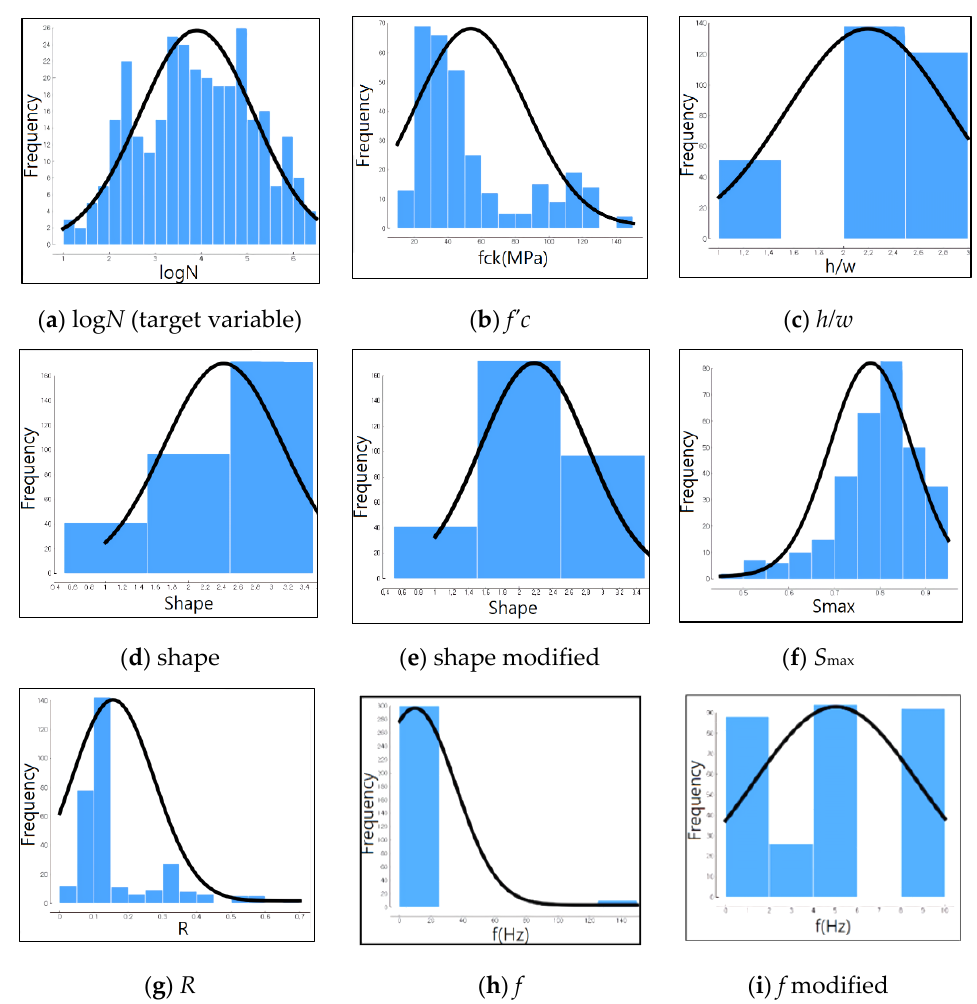
Figure 1. Distribution of frequency of the variables used to run the models. The relationships between various independent variables and log N are plotted in Figure 2. Although not strong, one linear relationship is identified in Figure 2a (log N vs. S max ). All other plots show non-linear behavior.